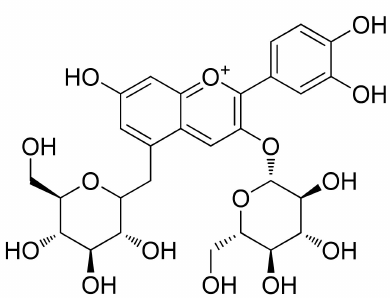
Figure 5. Chemical structure of cyanidin 3,5-diglucoside isolated from grape.